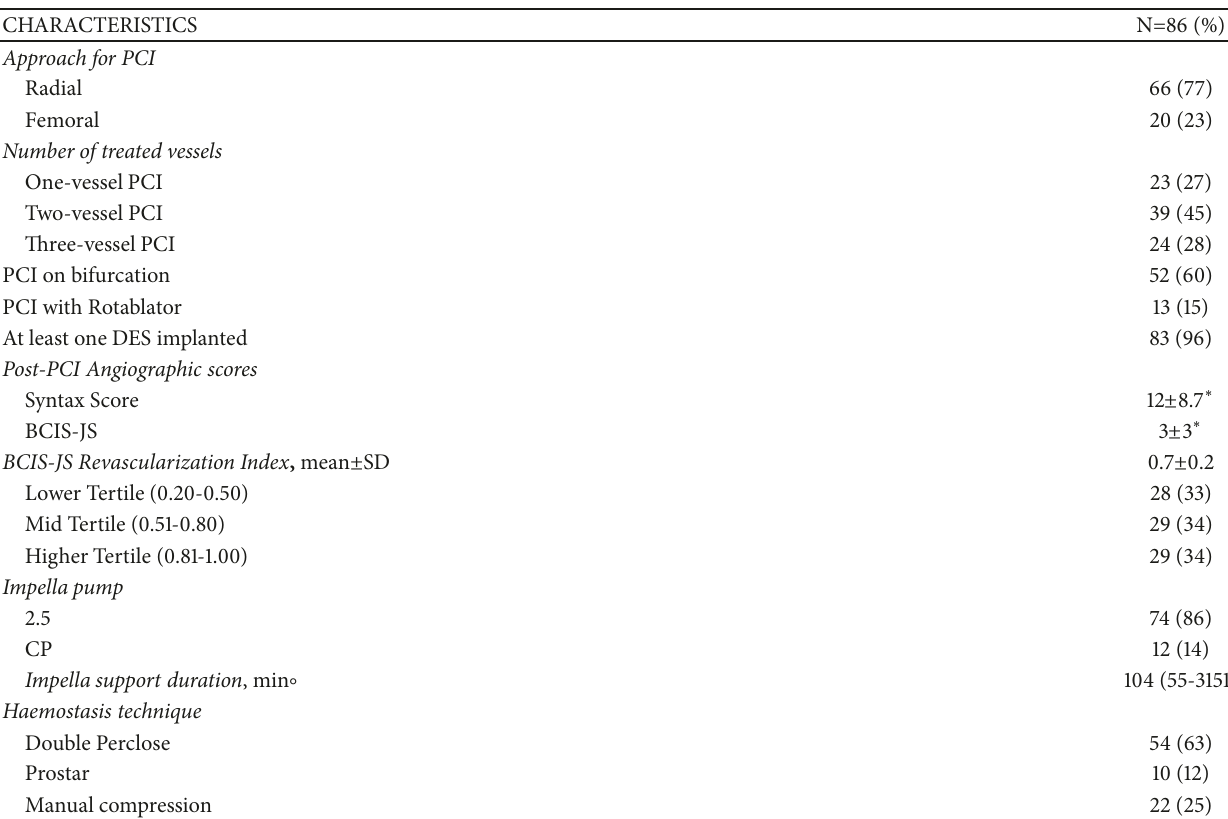
Table 2: Procedural characteristics.